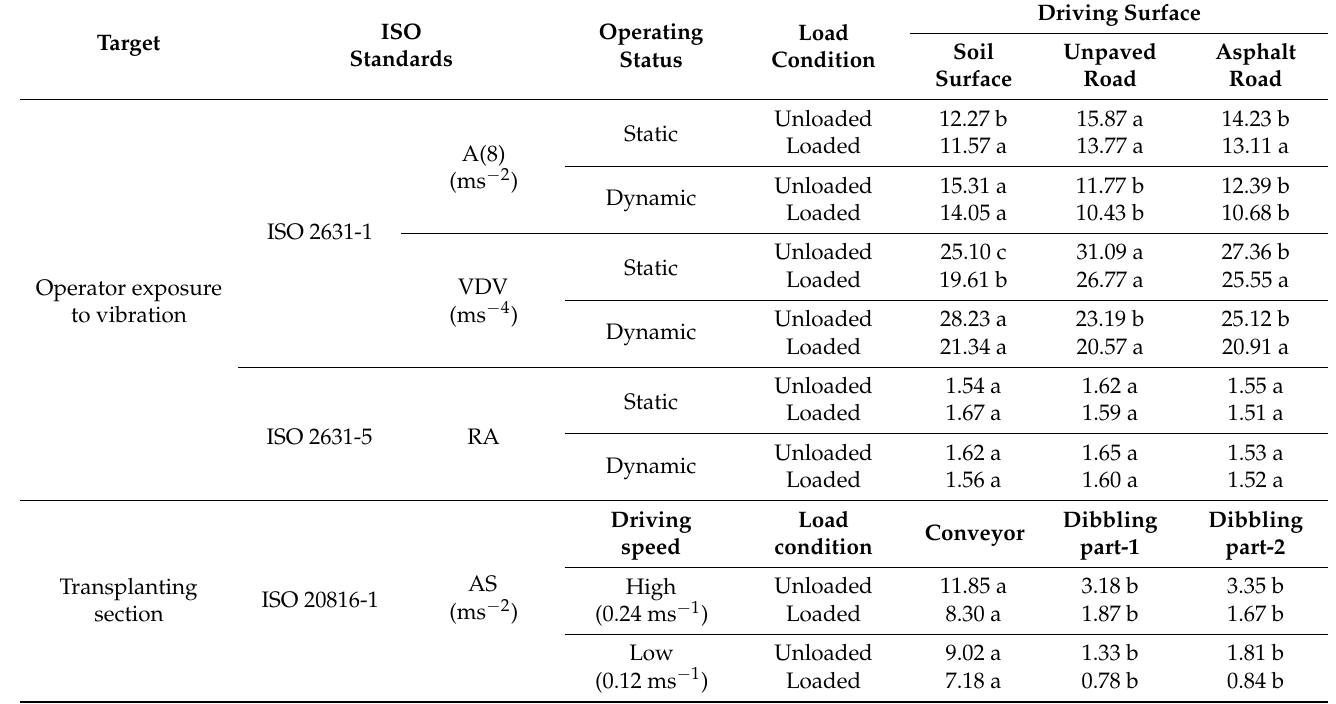
Table 8. Mean of measured vibrational exposure on different driving surfaces for different operational status, load conditions, and driving